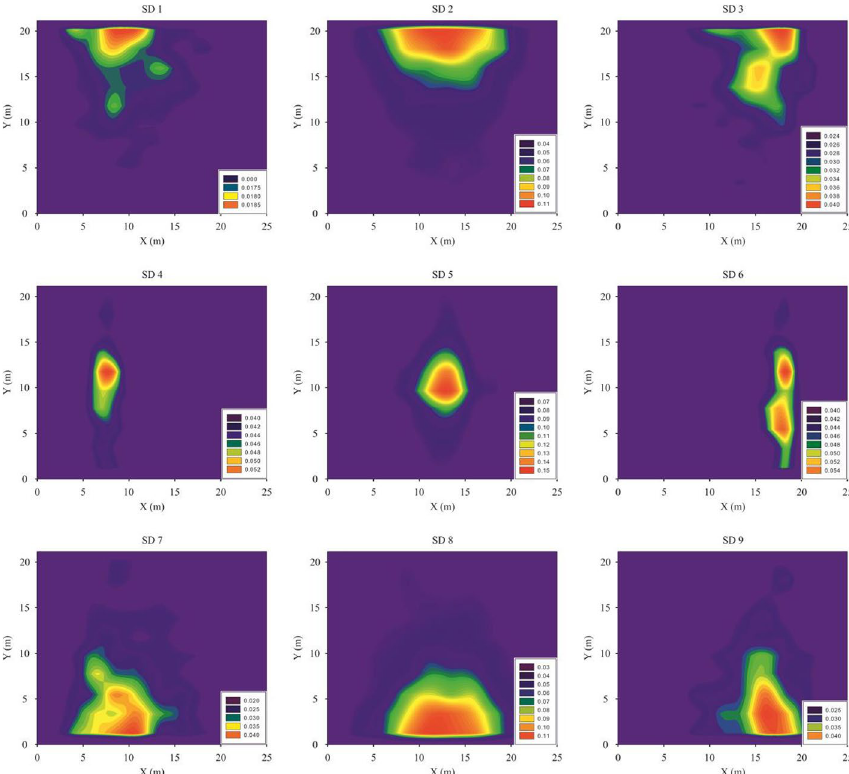
Fig. 18 Two-dimensional view of the detected damage extent for 9 single damage scenarios in the presence of